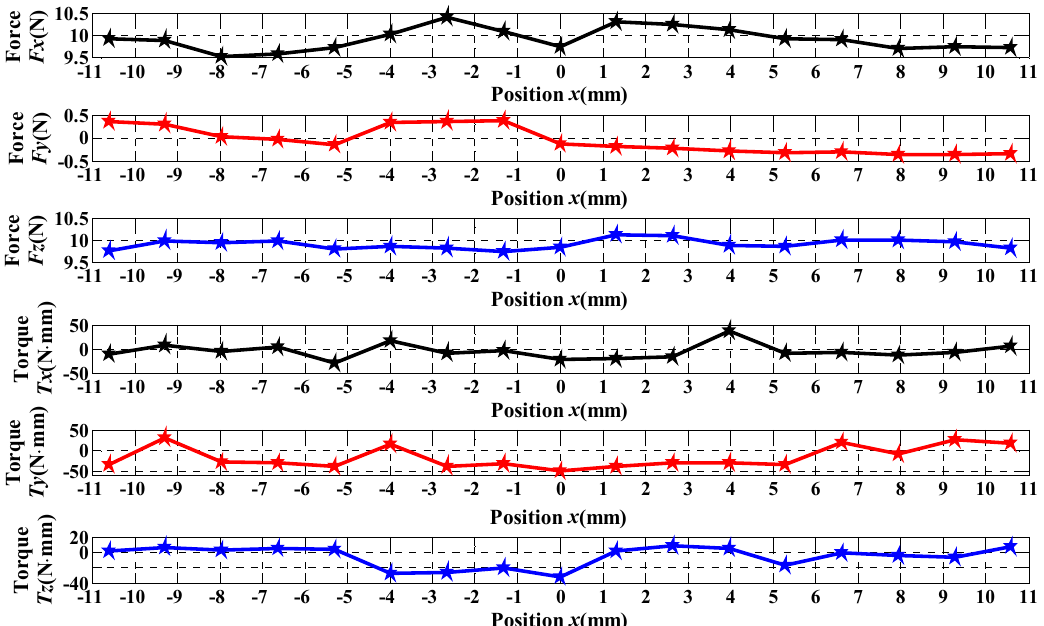
Figure 14. Results of 17 measured points of electromagnetic forces and torques when the desired electromagnetic forces/torques are W d = ( F x d , F y d , F z d , T x d , T y d , T z d ) T = (10 N, 0, 10 N, 0, 0, 0) T